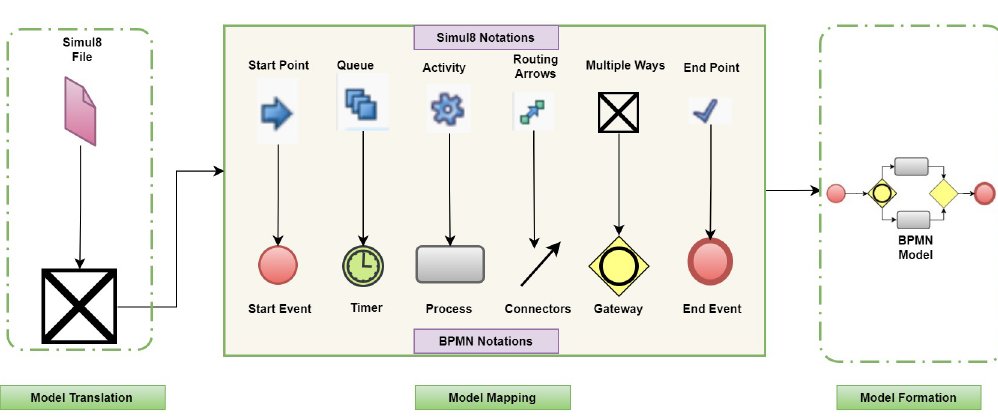
Fig 4. Simul8 to BPMN convertor takes Simul8 model file, maps the notation to BPMN and generates final model.